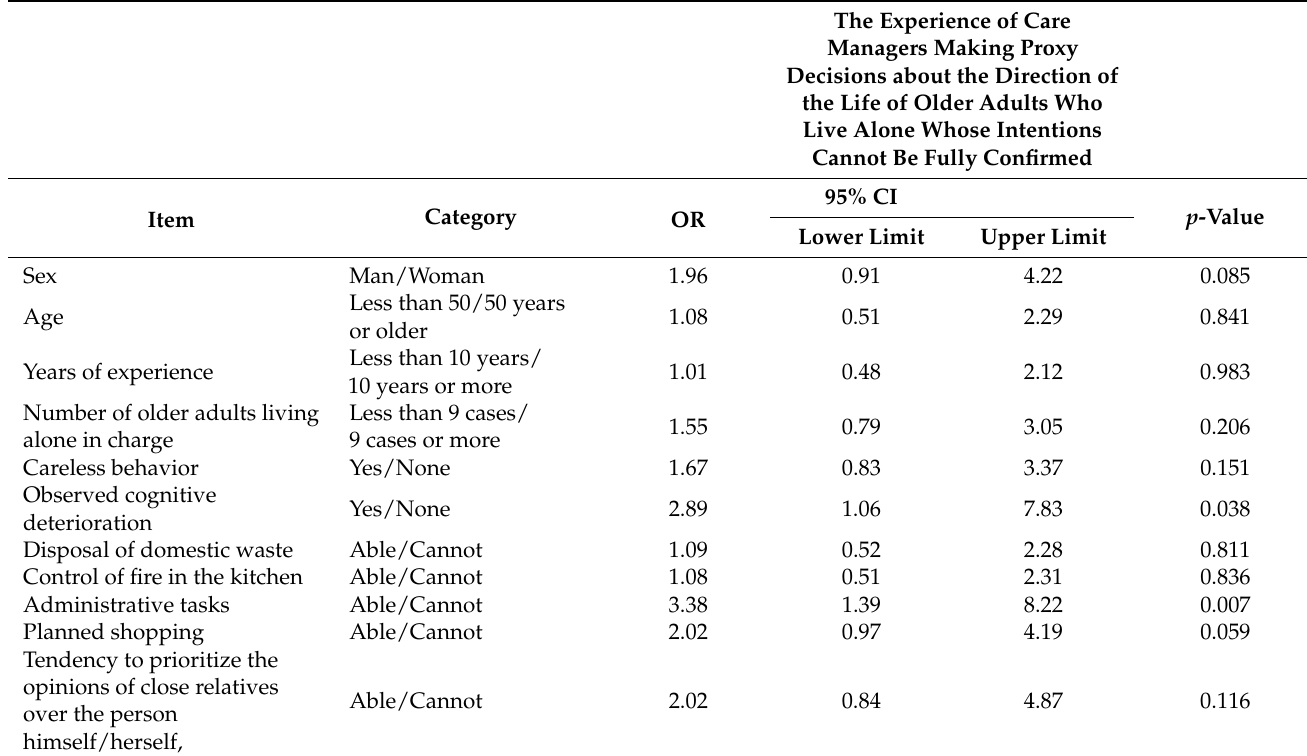
Table 2. Factors related to care managers’ experiences of making proxy decisions about the life direction of older adults living alone whose intentions could not be fully